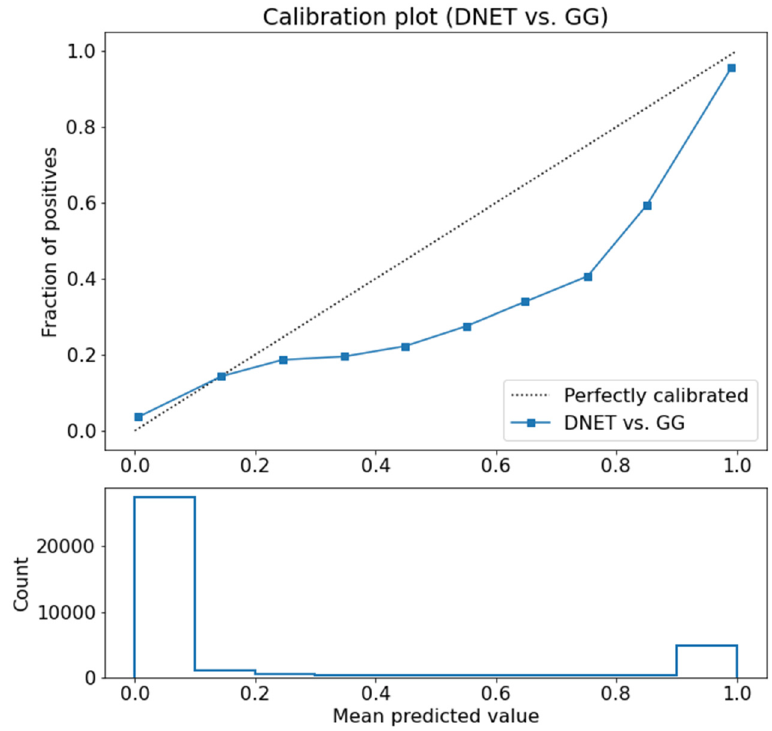
Figure 9. Results | Calibration plot. Figure 9. Results|Calibration